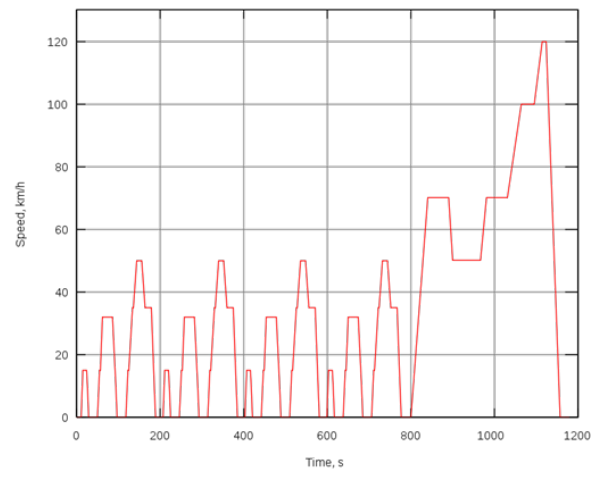
Fig. 3. Graphical representation of the NEDC testing procedure